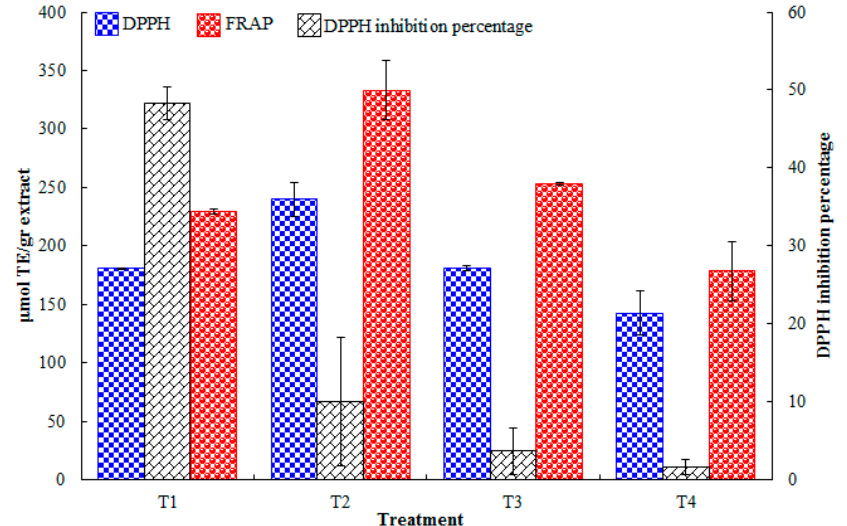
Figure 4. Scavenging activity of the supercritical H. inuloides extracts determined by the 2,2-diphenyl-1-picrylhydrazyl (DPPH) and Ferric Reducing Antioxidant Power (FRAP) assays. Results are expressed in DPPH inhibition percentage (primary vertical axis) and µmol Trolox Equivalents (TE)/g of extract (secondary vertical axis)